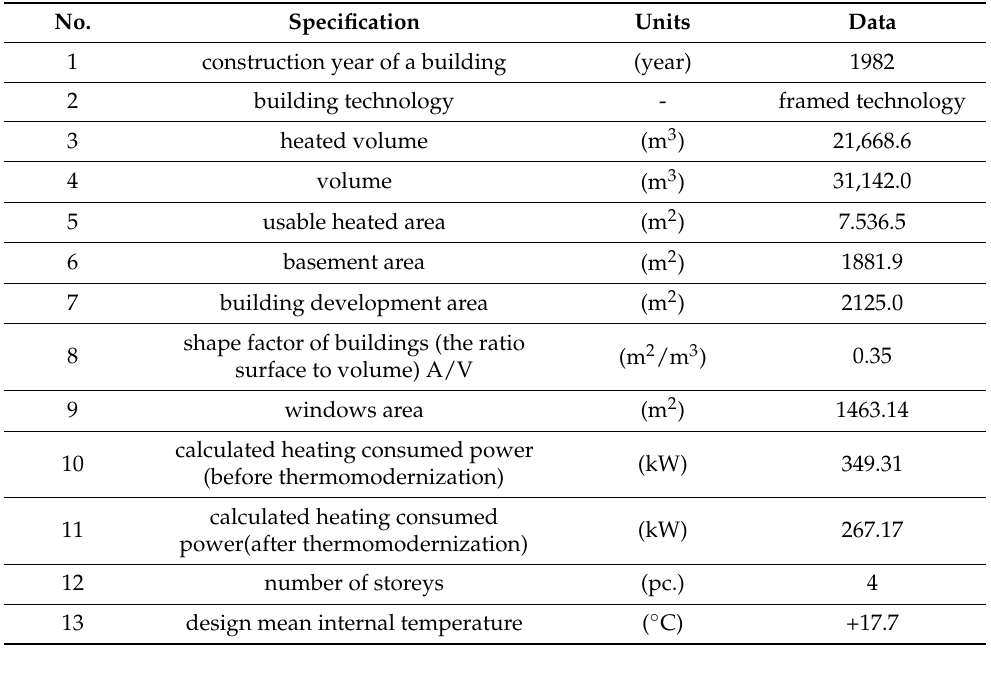
Table 2. Basic technical parameters of the building A [43].